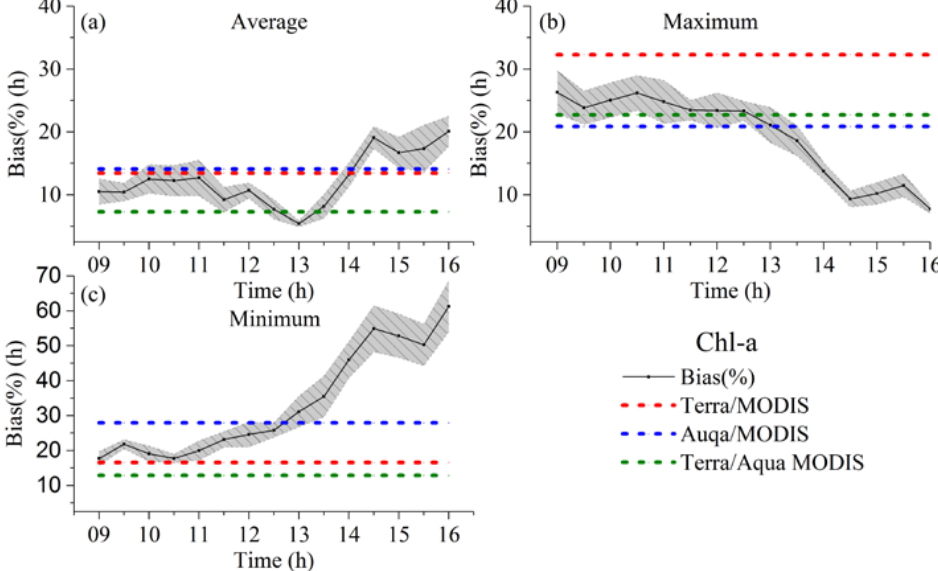
Figure 12. Biases (%) of the Chl-a level estimates for average ( a ), maximum ( b ), and minimum ( c ) as a function of measurement time